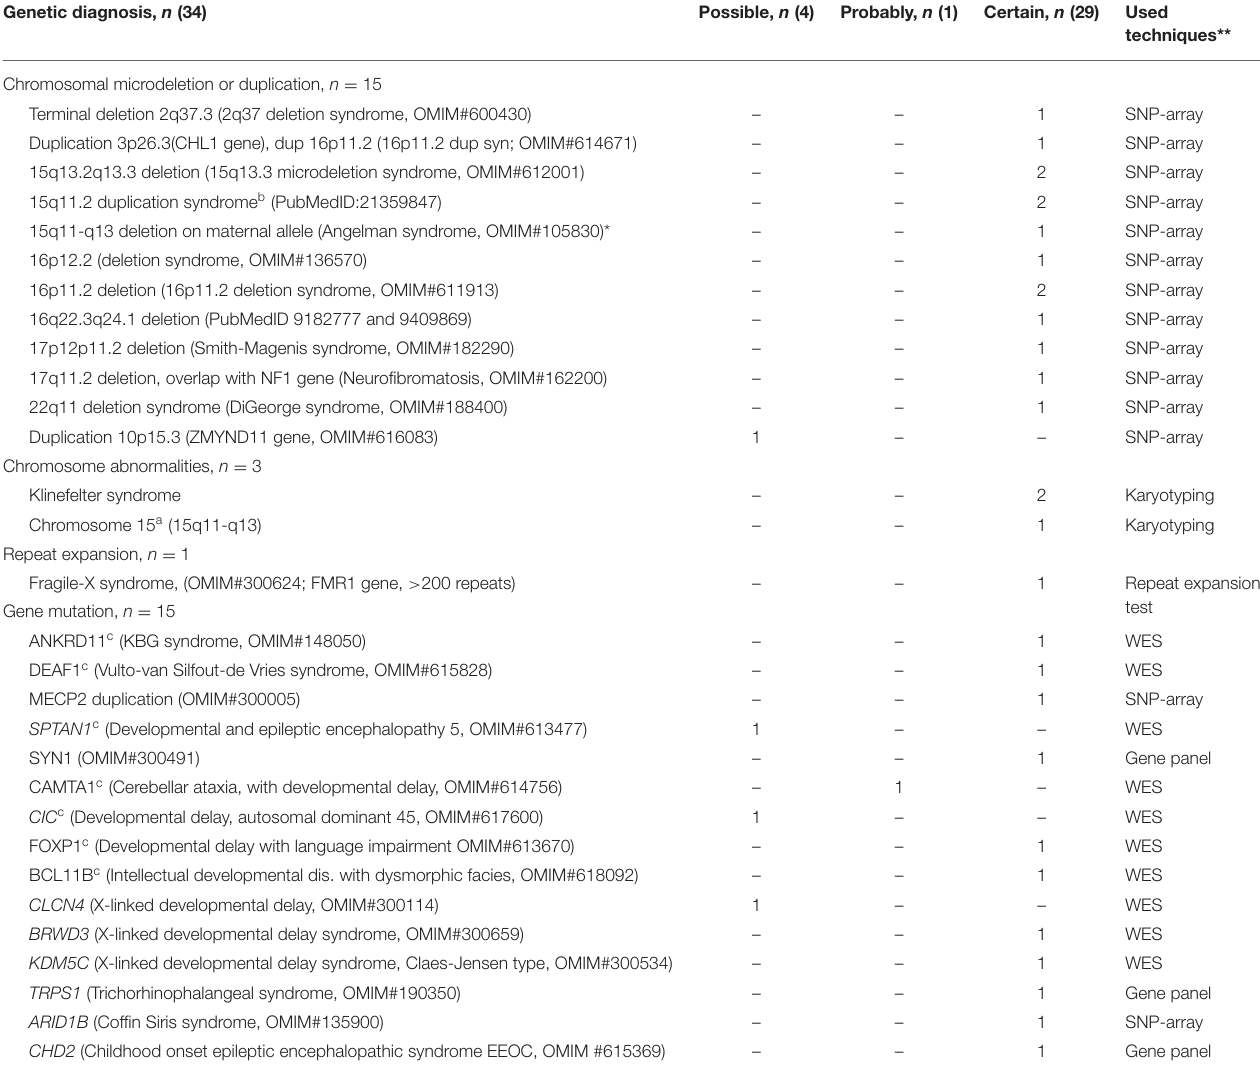
TABLE 4 | Genetic outcome of children diagnosed with an etiological cause for developmental language delay (DLD). Genetic diagnosis, n (34) Possible, n (4) Probably, n (1) Certain, n